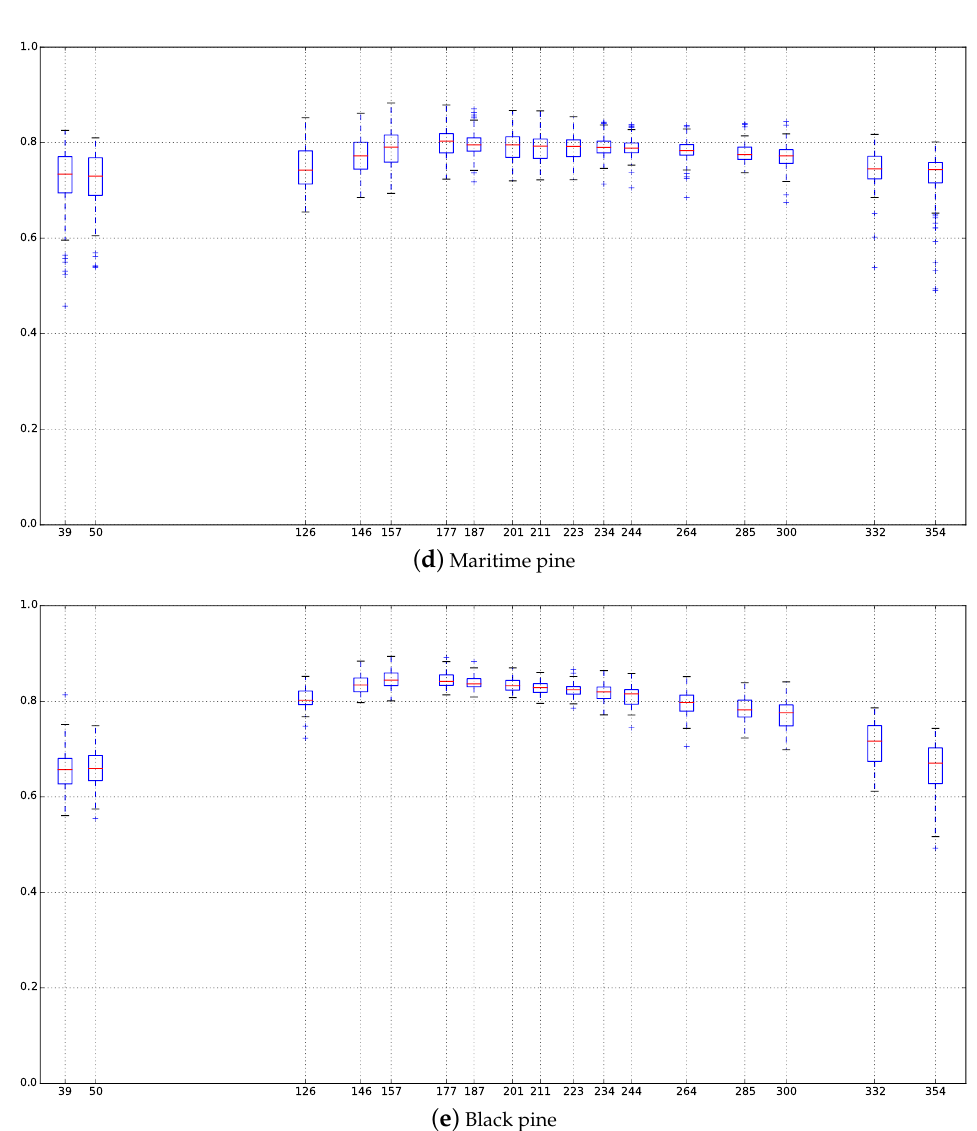
Figure C2. Seasonal dynamic of NDVI distribution among conifer tree species: Douglas fir ( a ), Silver fir ( b ), Corsican pine ( c ), Maritime pine ( d ), Black pine ( e ). Boxplots (medians and the interquartile range from 1st to 3rd quartiles) are defined for each date of the year ( x-axis ) of the Formosat-2 time series of